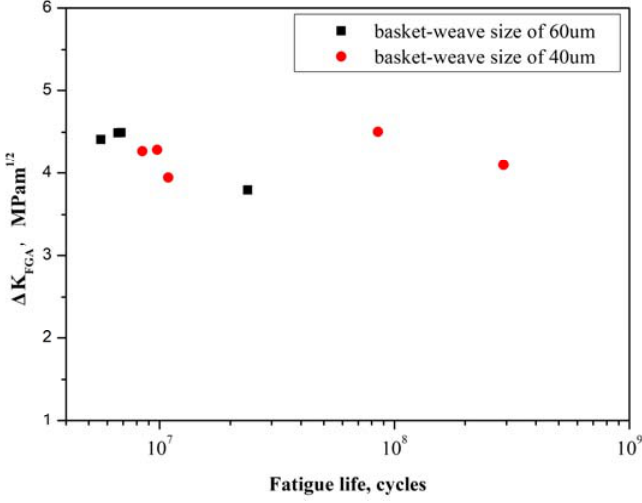
Figure 8. Relationship between the stress intensity factor range at FGA and fatigue life.